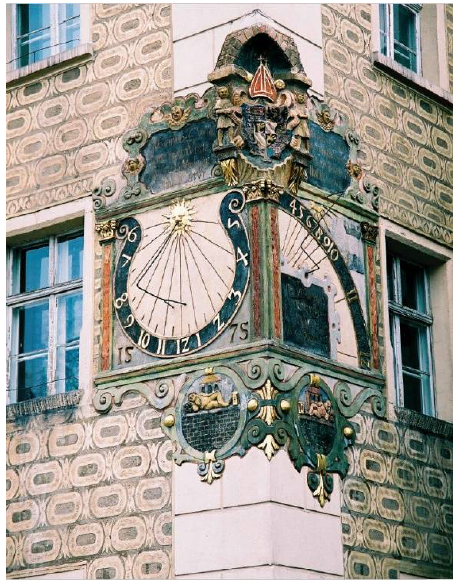
Figure 16. Fragment of the decoration of the town hall in Otmuchów. Photo author, 2016.